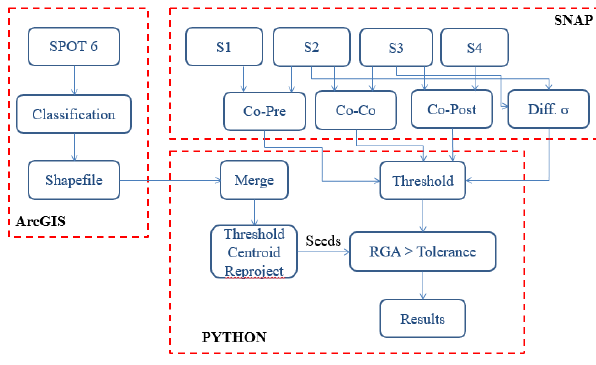
Figure 2. Block diagram of the floodwater-mapping algorithm 3.1 Change Detection Using the Interferometric Coherence and Intensity